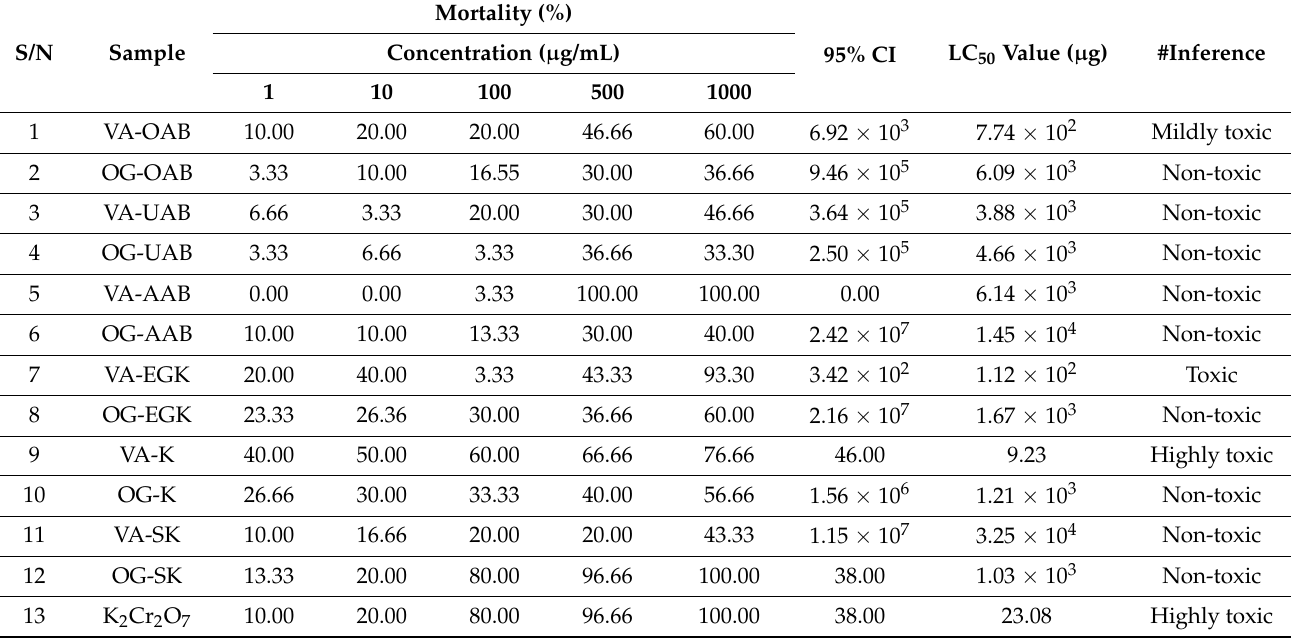
Table 4. Brine shrimp lethality of aqueous extracts of VA and OG